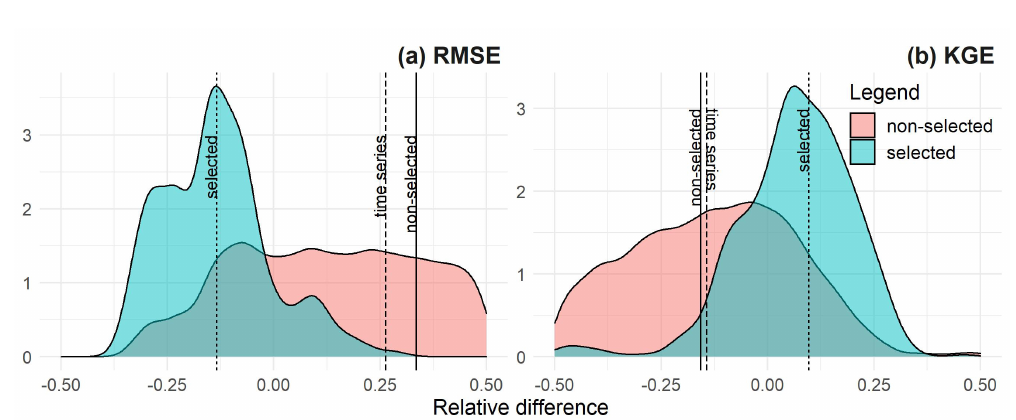
Figure 4. The density of differences in RMSE ( a ) and KGE ( b ) between expert calibration and the rest of the objective functions (OFs). The dotted line corresponds to mean of the selected best-performing OFs, the dashed line to the mean for the OFs, including time series, and the solid line to the mean of the OFs that were not